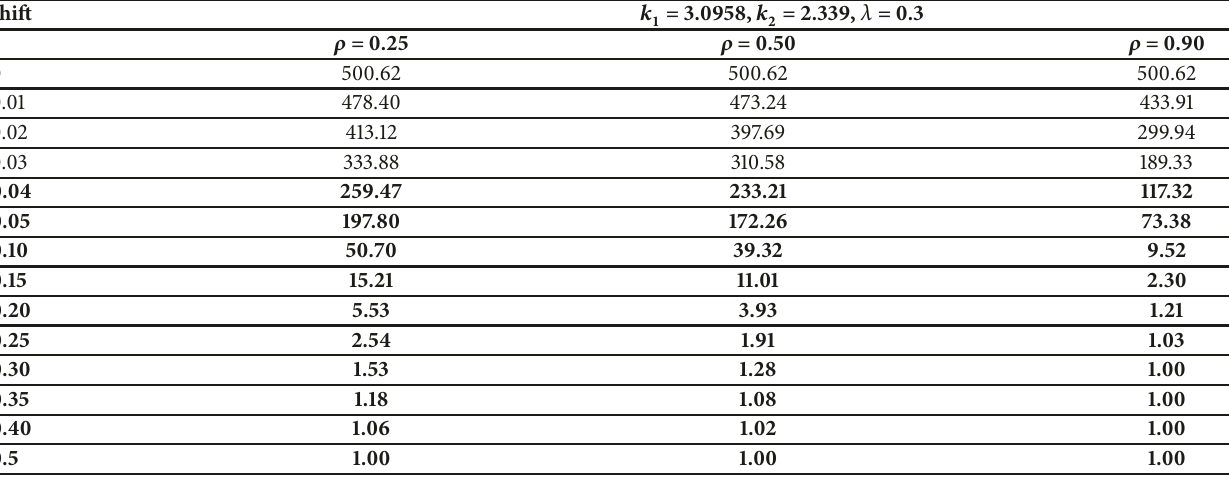
Table 3: ARLs for proposed repetitive EWMA-RSS control chart using Bahl and Tuteja (1991) exponential ratio-type estimator, when 𝑟 𝑜 is 500.